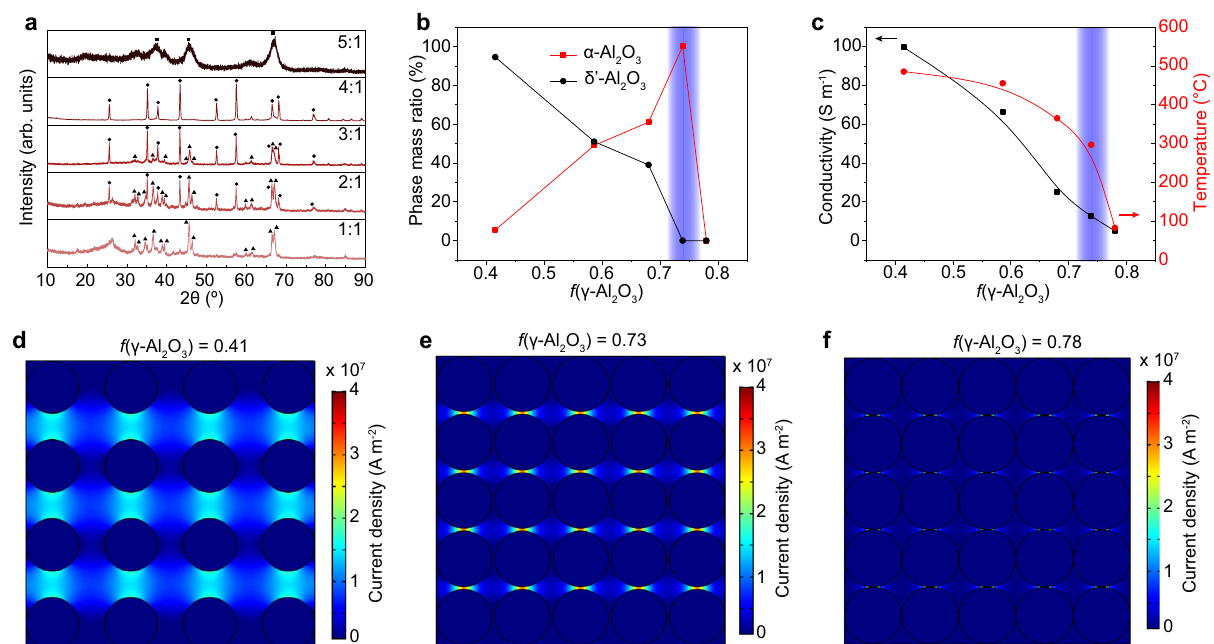
Fig. 3 | Resistive hotspot effect in pulsed direct current (PDC) process. a X-ray diffraction (XRD) patterns of γ -Al 2 O 3 /CB with different mass ratios after the same PDCprocess. The marksare γ -Al 2 O 3 (square), δ ʹ -Al 2 O 3 (triangle),and α -Al 2 O 3 (dot). Thenumbersarethemassratioof γ -Al 2 O 3 tocarbonblack(CB). b Phasemassratios of theproductafterPDC processvariedwithvolumefractionof γ -Al 2 O 3 , f ( γ -Al 2 O 3 ). The blue region denotes the pure α -phase at f =0.73. c Conductivities and